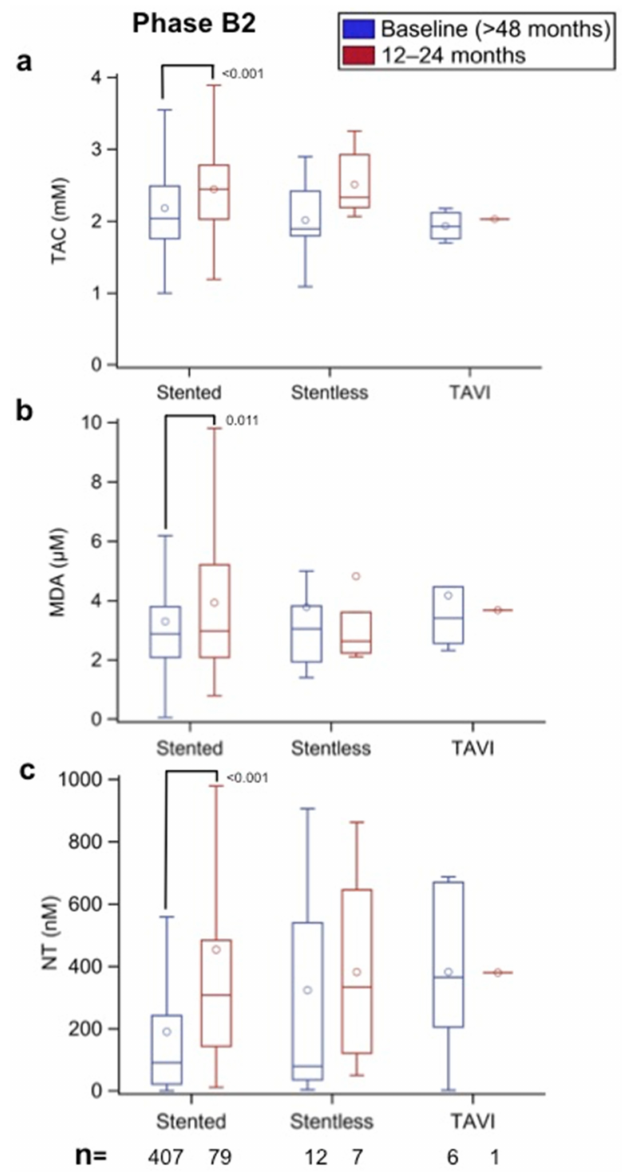
Figure 8. ( a ) Total antioxidant capacity (TAC, in mm), ( b ) malondialdehyde (MDA, in µ m), and ( c ) nitrotyrosine (NT, in nm) values in Phase B2 patients with bovine pericardium aortic biological heart valves according to the type of framework (stented, stentless, TAVI) at the time of recruitment (>48 months after aortic valve replacement) and after 12- to 24-month follow-up (>60–72 months after aortic valve implantation). The numbers within the figures represent the p -values, and the numbers at the bottom of the figures represent the number of assessed patients. Multiple comparison adjustments were performed with Dunnett’s and Tukey–Kramer’s